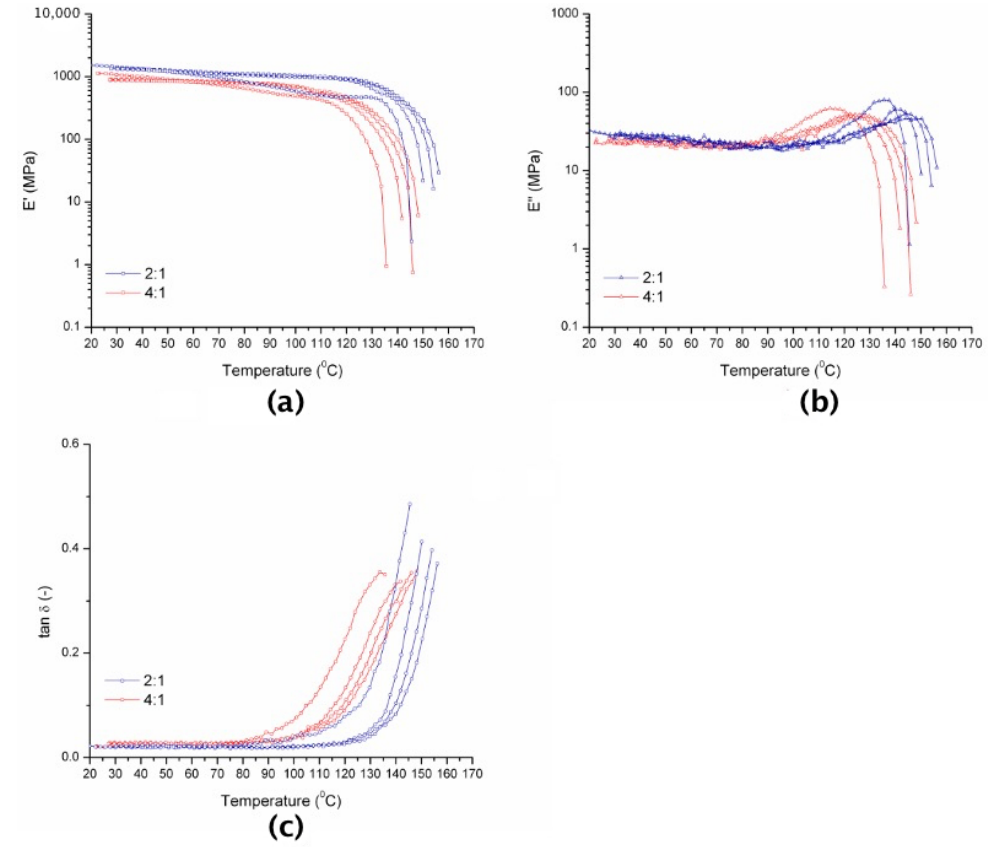
Figure 5. DMTA of various specimens of PE-fur/Bism ( a ) Storage modulus E’. ( b ) Loss modulus E”. ( c ) Damping factor tan δ. Only the heating steps are shown for clarity.